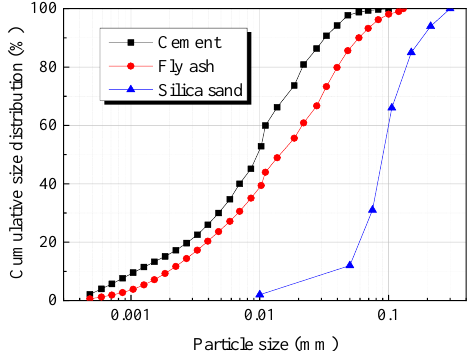
Figure 2. Particle size distribution of raw